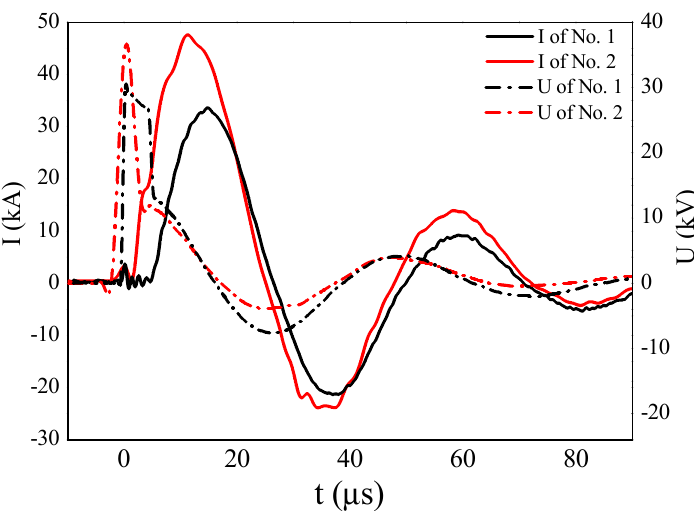
Figure 8. Typical discharge current and voltage curves of liquid pulsed discharge in micro graphite flake suspension.